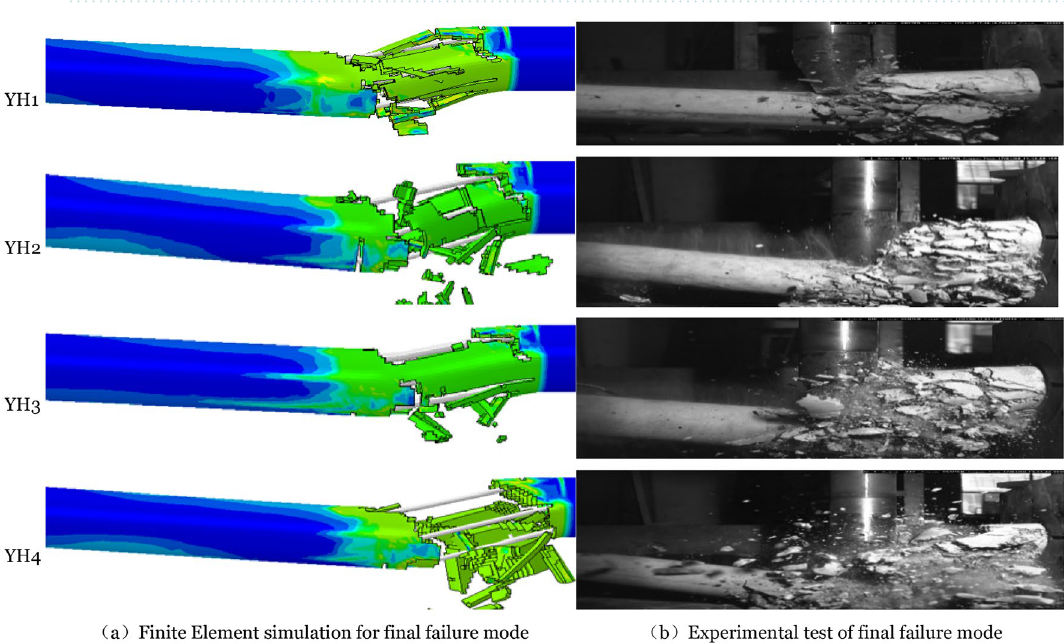
Figure 6. Compared the final failure